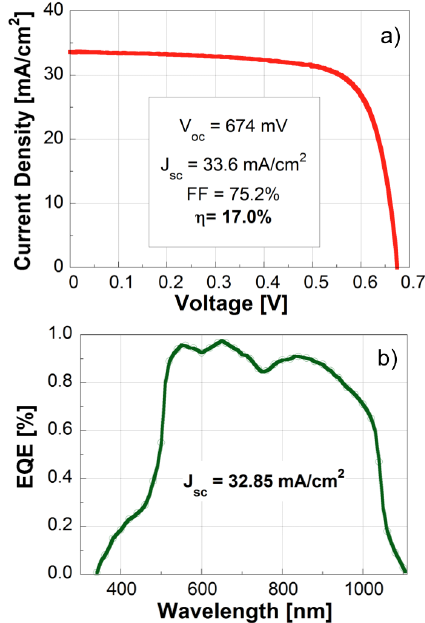
Figure 7. ( a ) Current-voltage characteristics of a test solar cell under the illumination of a class-A solar simulator; ( b ) External quantum efficiency spectrum of the same cell.